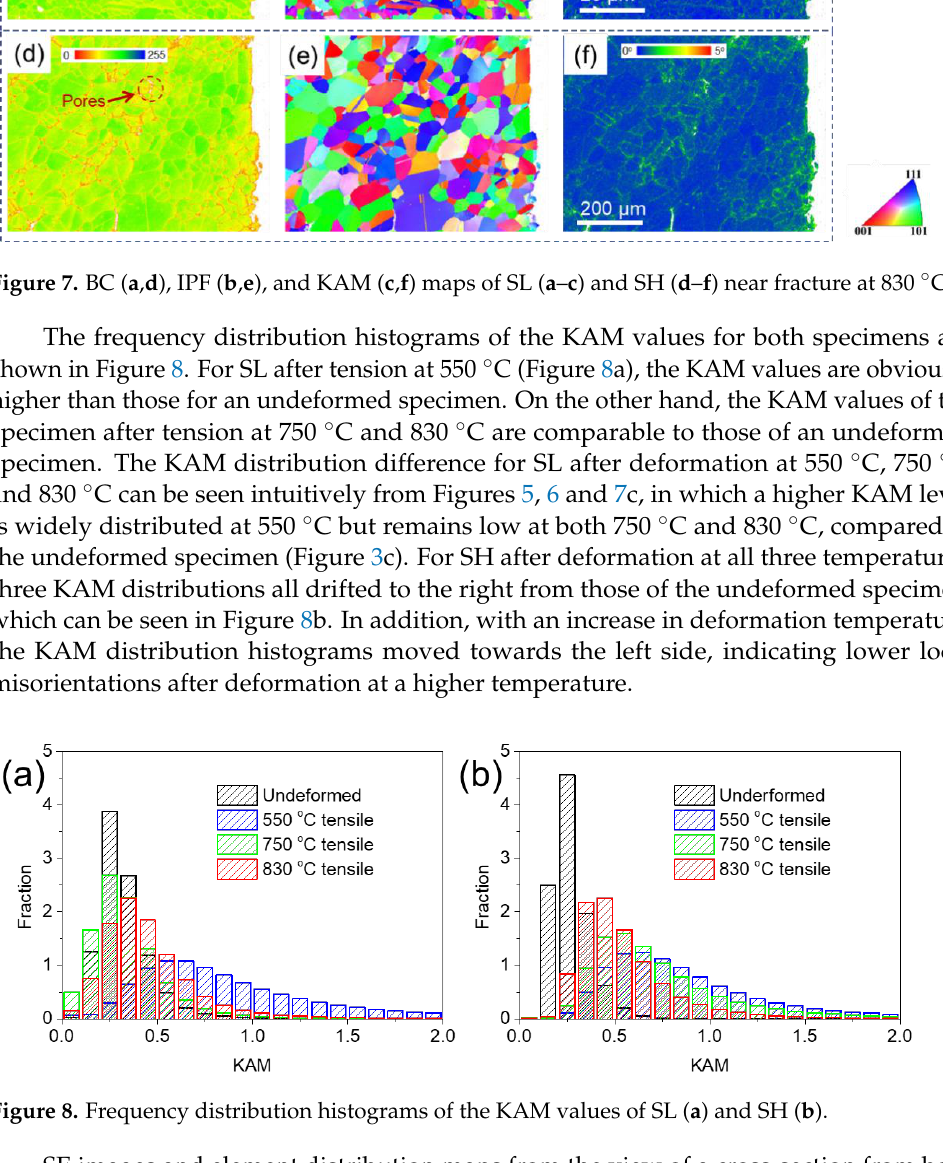
Figure 9. SE images ( a , c ) and element distribution maps ( b , d ), of the cross-sections for SL ( a , b ) and SH ( c , d ). The fracture surfaces of SL at 550 °C, 750 °C, and 830 °C are shown in Figure 10. Macro fractographies can be seen from Figure 10a – c, and the corresponding high- resolution images are also given in (a ’– c ’ ), respectively. It can be seen from Figure 10a – c that the fracture surface at 550 °C is relatively intact, but some warped layers show up when testing at 750 °C. With an increase in testing temperature to 830 °C, warped layers are more severe compared to those at 750 °C, which can be seen clearly in Figure 10c. With SE images taken wi th a high resolution (Figure 10a’–c’), more details about the fracture surface can be observed. Dimples are dominant on the fracture surface at 550 °C (Figure 10a’), but can hardly be seen on that at both 750 °C and 830 °C (Figure 10b’,c’). Instead of dimples, intergranular fractures and intergranular cracks can be observed on